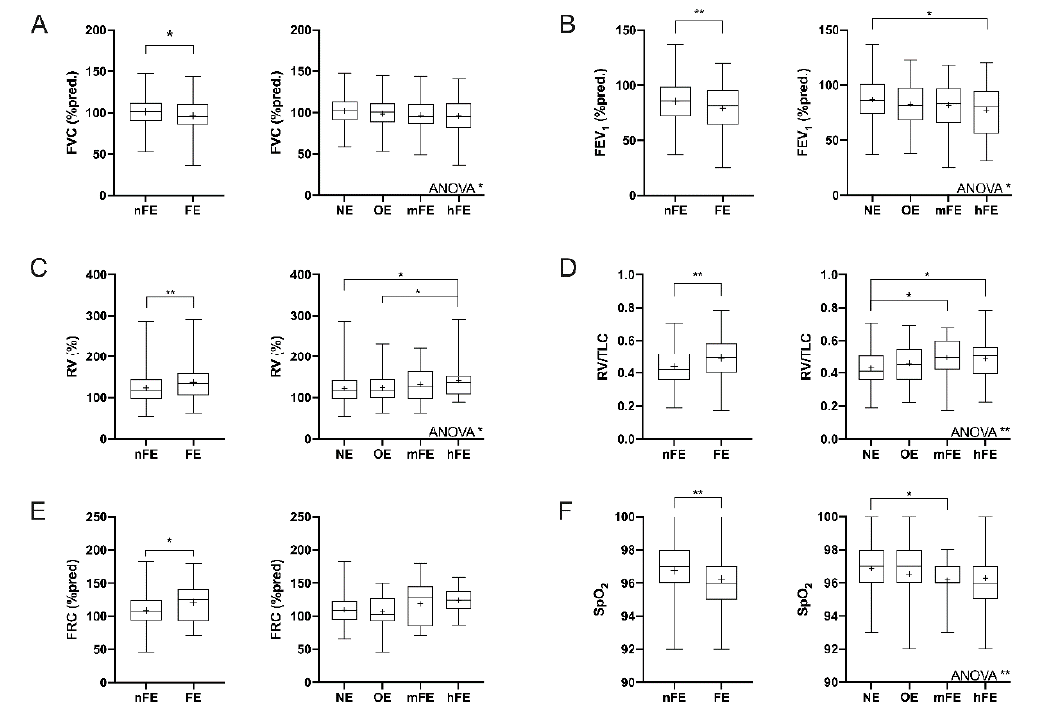
Figure 1. Functional parameters in the asthmatic population after stratification according to the number of exacerbations. ( A ) FVC %pred; ( B ) FEV 1 %pred; ( C ) RV % (%pred); ( D ) RV/TLC ratio; ( E ) FRC %pred; ( F ) blood oxygen saturation. Box plots represent data from the first to the third quartile; whiskers represent the minimum and maximum values; “ + ” indicates the mean value. nFE: nonfrequent exacerbator; FE: frequent exacerbator; NE: non-exacerbator; OE: occasional exacerbator; mFE: mildly frequent exacerbator; hFE: highly frequent exacerbator; ANOVA: analysis of variance. * p < 0.05; ** p < 0.01.